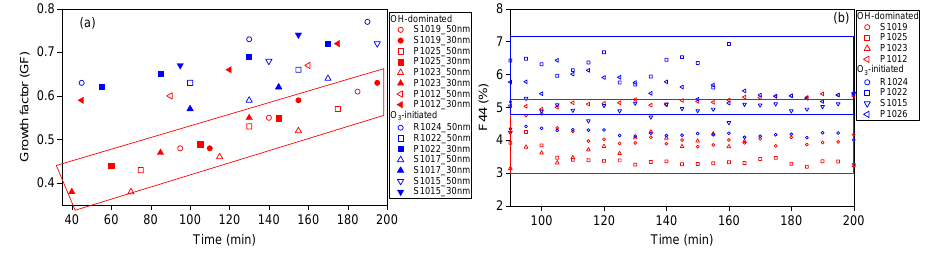
Fig. 5. (a) Volatility growth factor determined by V-TDMA for 30 nm and 50 nm SOA at temperature of 150 ◦ C. (b) The fraction of m/z 44 to total organic mass (F44), a proxy for oxidation state, as measured by the Q-AMS. Red markers are presented for the OH-dominated chemistry and blue markers are for O 3 -initiated systems. No V-TDMA measurement was made in P1026. F44 from S1017 is noisy due to the low aerosol mass (Table 2) and are not shown in Fig. 5b.